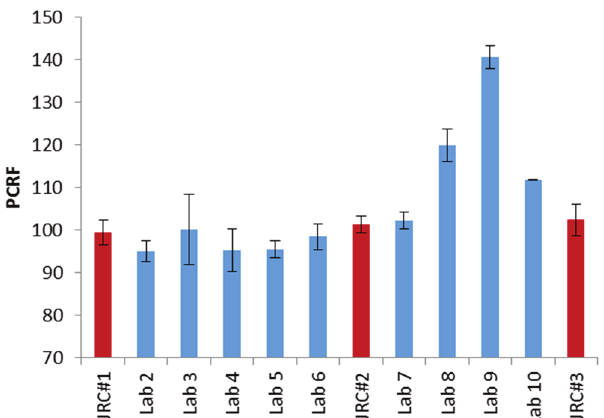
Fig. 1. Average Particle number Concentration Reduction Factors (PCRF) at 30, 50 and 100 nm graphite particles with the Golden aerosol generator and the Golden CPC at different laboratories [17]